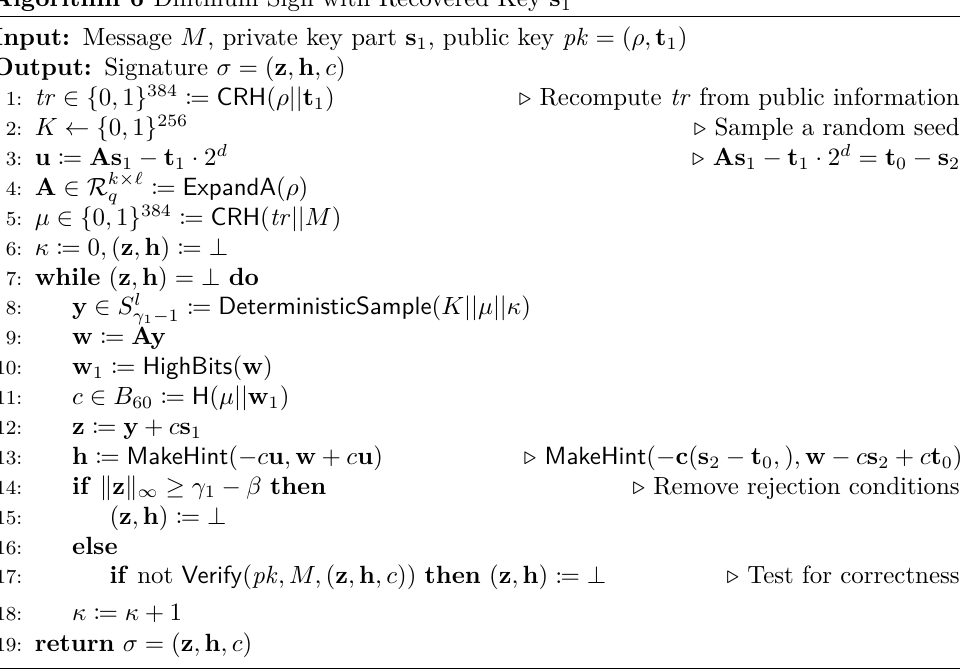
Algorithm 6 Dilithium Sign with Recovered Key s